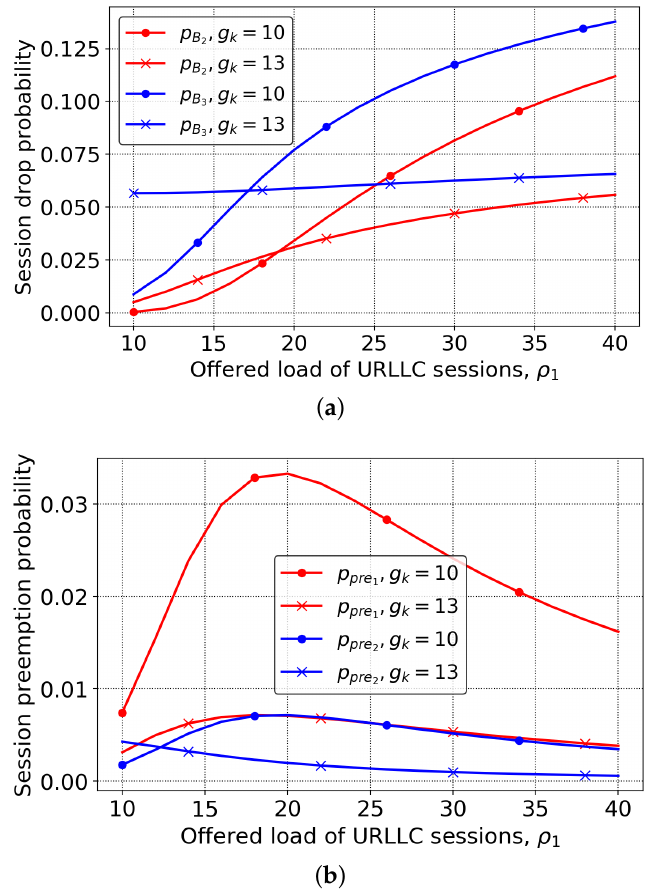
Figure 4. Drop and pre-emption probabilities: ( a ) eMBB and mMTC drop probabilities, ( b ) URLLC and eMBB pre-emption probabilities.